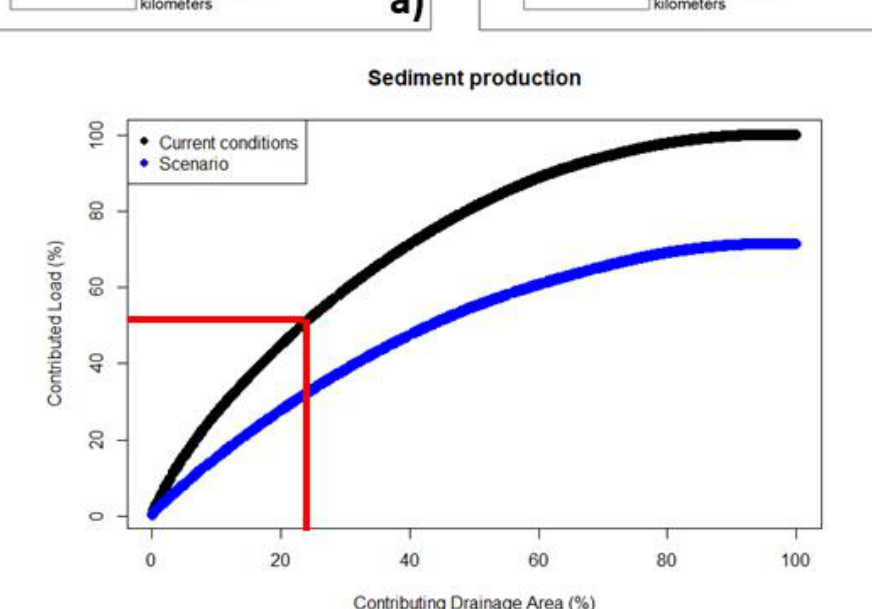
Figure 12. a) Sub-watershed sediment yield by gully erosion. b) Total sediment yield by sub- Figure 12. ( a ) Sub-watershed sediment yield by gully erosion. ( b ) Total sediment yield by sub-watershed within the Los Laureles Canyon watershed and ( c ) total sediment production by contributing the drainage area under the current conditions and road-paved